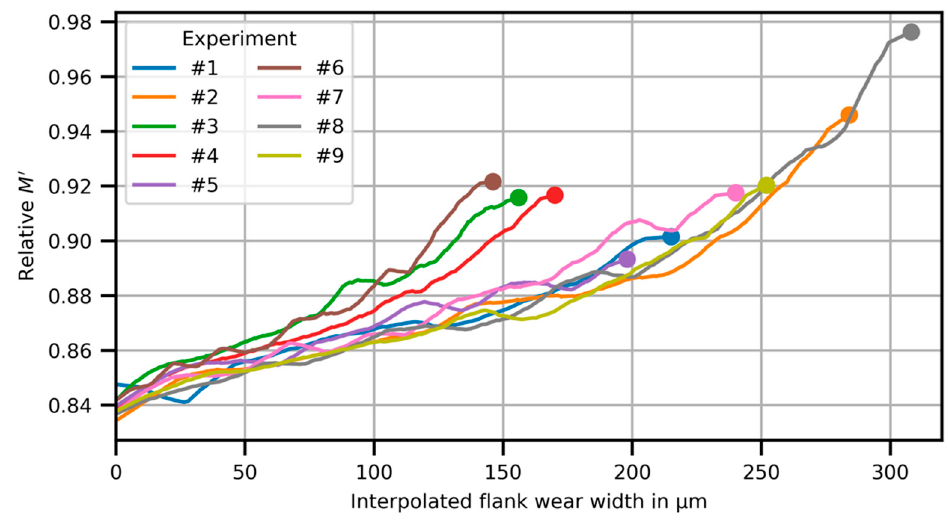
Figure 7. Apart from experiments #3, #4, and #6, the experiments align well with each other.